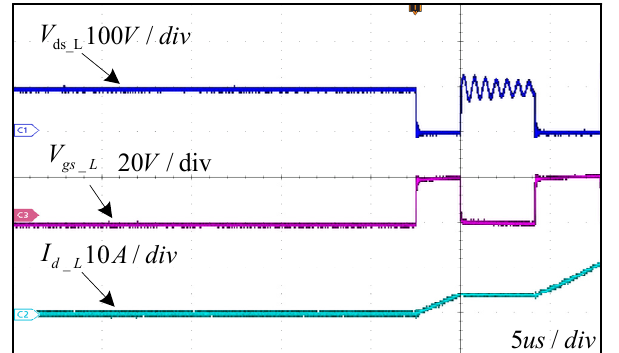
Figure 2. Double Pulse Test of SiC Three ‐ phase Full Bridge.